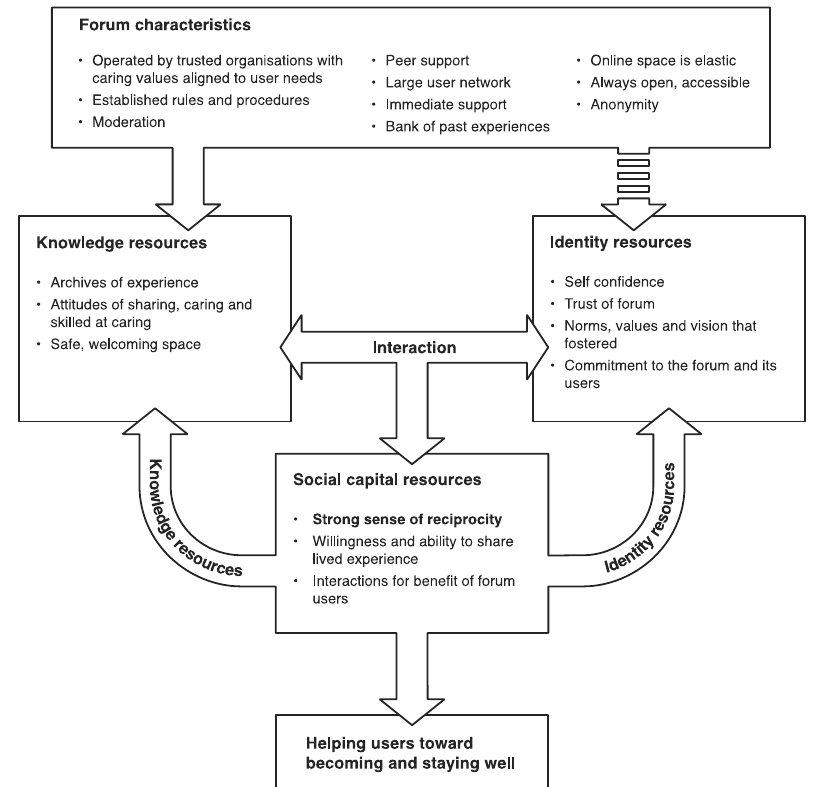
Figure 2. How online mental health peer support forums build and share social capital resources to help rural users maintain better mental wellness.